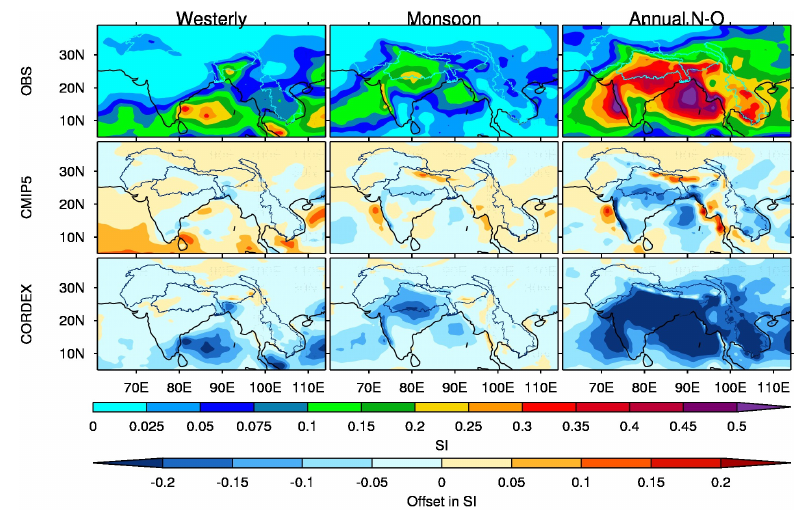
Figure 7. Top panel for precipitation, middle panel for relatively entropy (RE) and bottom panel for seasonality index (SI). The first row of each panel shows OBS P, RE and SI while the second and third rows show the offsets of CMIP5 and CX-SA ensemble means relative to OBS ensemble mean, respectively.